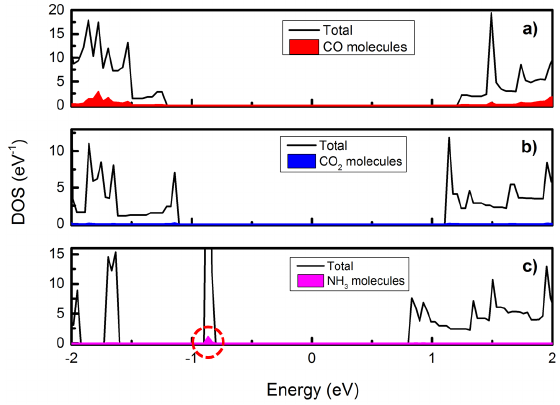
Figure 4: TDOS of systems: a) C-H-N:SSPGNR(CO); b) C-H-N:SSPGNR(CO 2 ); c) C-H-N:SSPGNR(NH 3 ) and LDOS of the gas molecules (the filled area under the DOS